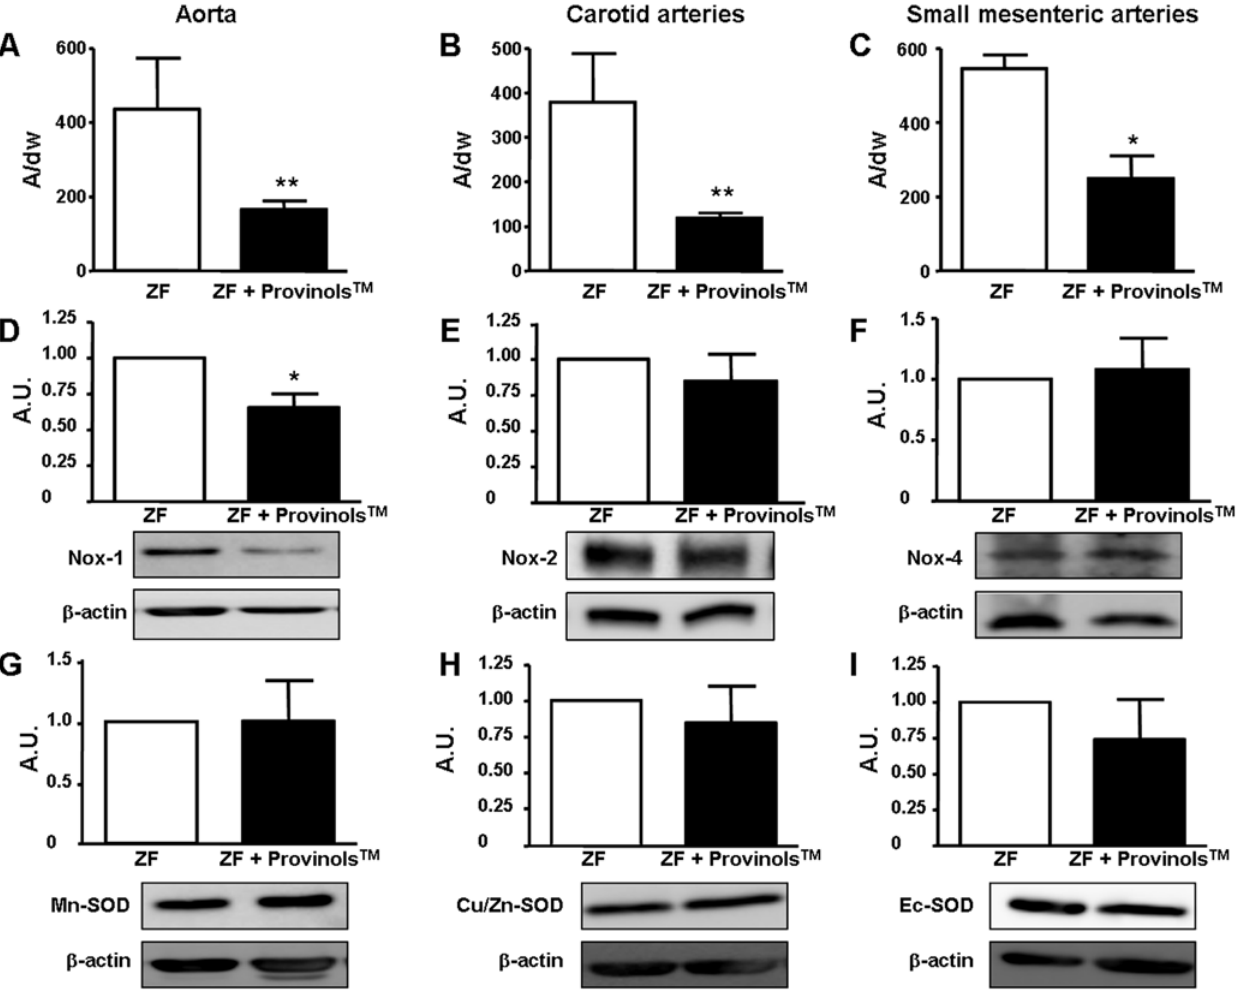
Figure 5. Provinols TM reduce O 2 2 vascular release in vessels from ZF rats. O 2 2 production in aorta (A), carotid arteries (B) and small mesenteric arteries (C) from Zucker fatty (ZF) and ZF + Provinols TM rats. Values are expressed as units of amplitude (A)/mg weight of dried tissue (dw). Western blots revealing expression of Nox-1 (D), Nox-2 (E), Nox-4 (F), Mn-SOD (G), Cu/Zn-SOD (H) and Ec-SOD (I) in aorta expressed as arbitrary units (A.U.). ( n =6). * P , 0.05, ** P , 0.01 vs. ZF